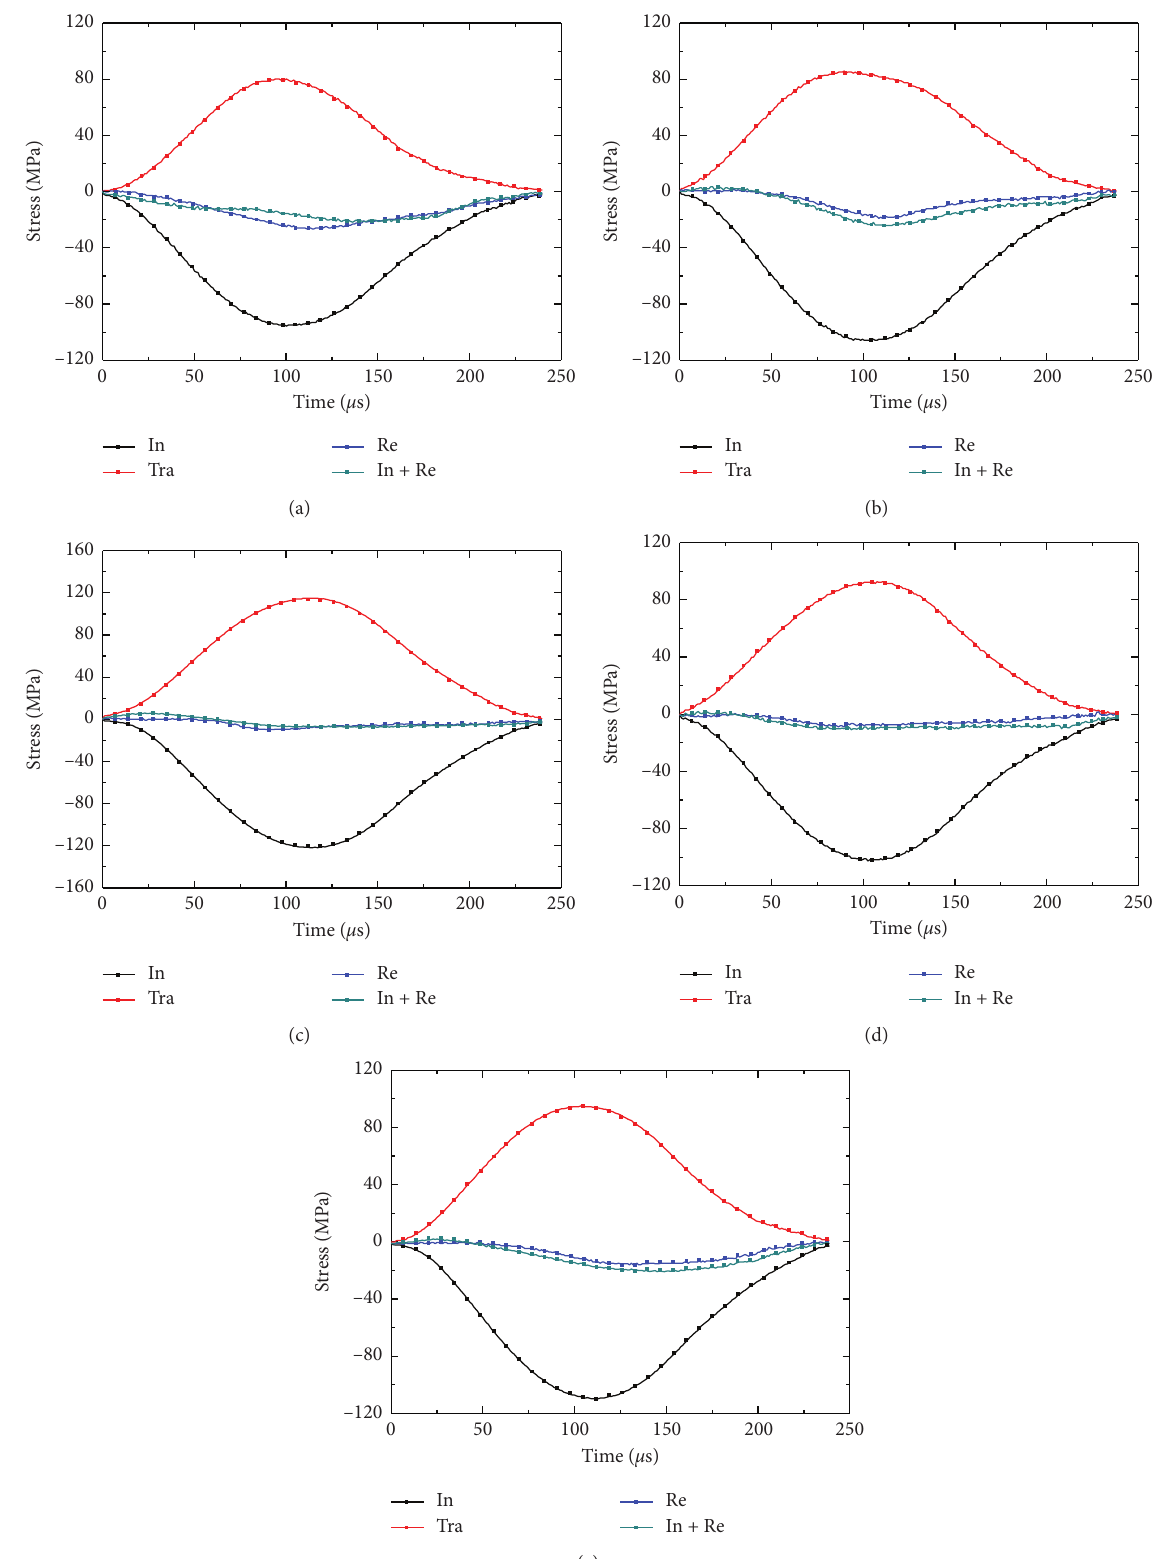
Figure 7: Stress equilibrium check for each dip angle. (a) θ � 0 ° , (b) θ � 30 ° , (c) θ � 45 ° , (d) θ � 60 ° , and (e) θ � 90 °